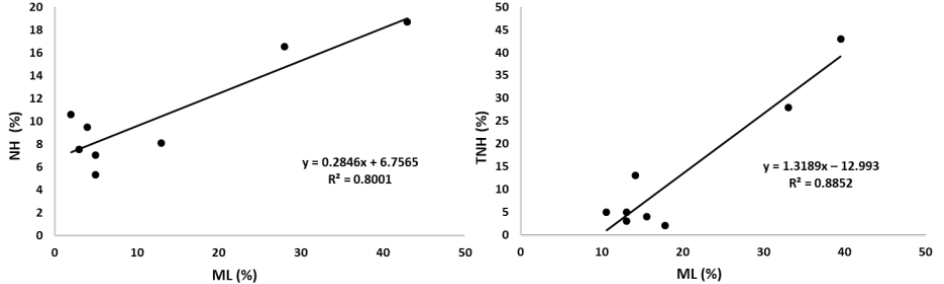
Figure 5. Correlations between the non-hydrolysable fractions and the mixed layers. NH: non-hydrolysable fraction, biochemically protected; TNH: NH plus µ NH (non-hydrolysable fraction, physically protected); ML: mixed layers.